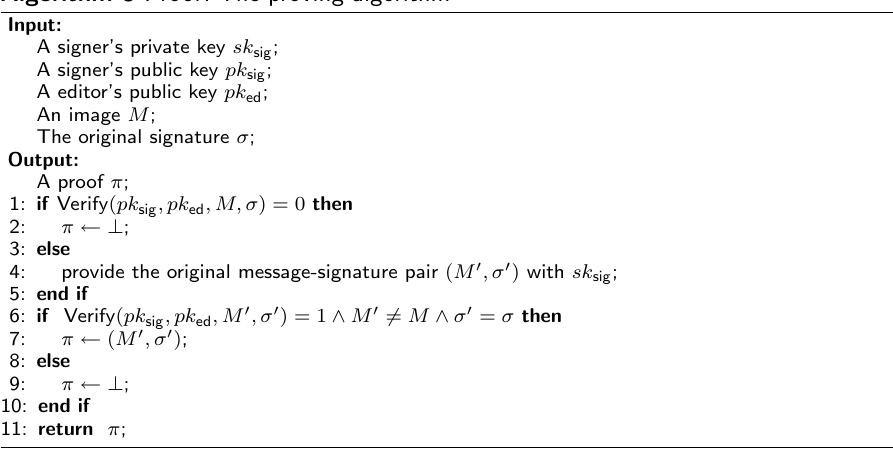
Algorithm 4 takes the signer’s public key pk sig , the edi- Algorithm 6 takes the signer’s public key pk sig , the tor’s public key pk ed , an image M , a signature σ and an 0, 1 } editing rule ER as input. It outputs a bit b ∈ { . The algorithm is run by a verifier to detect the authenticity of 1 the image. If b = , the image is authentic; otherwise, the image is untrusted. Algorithm 5 Proof: The proving algorithm